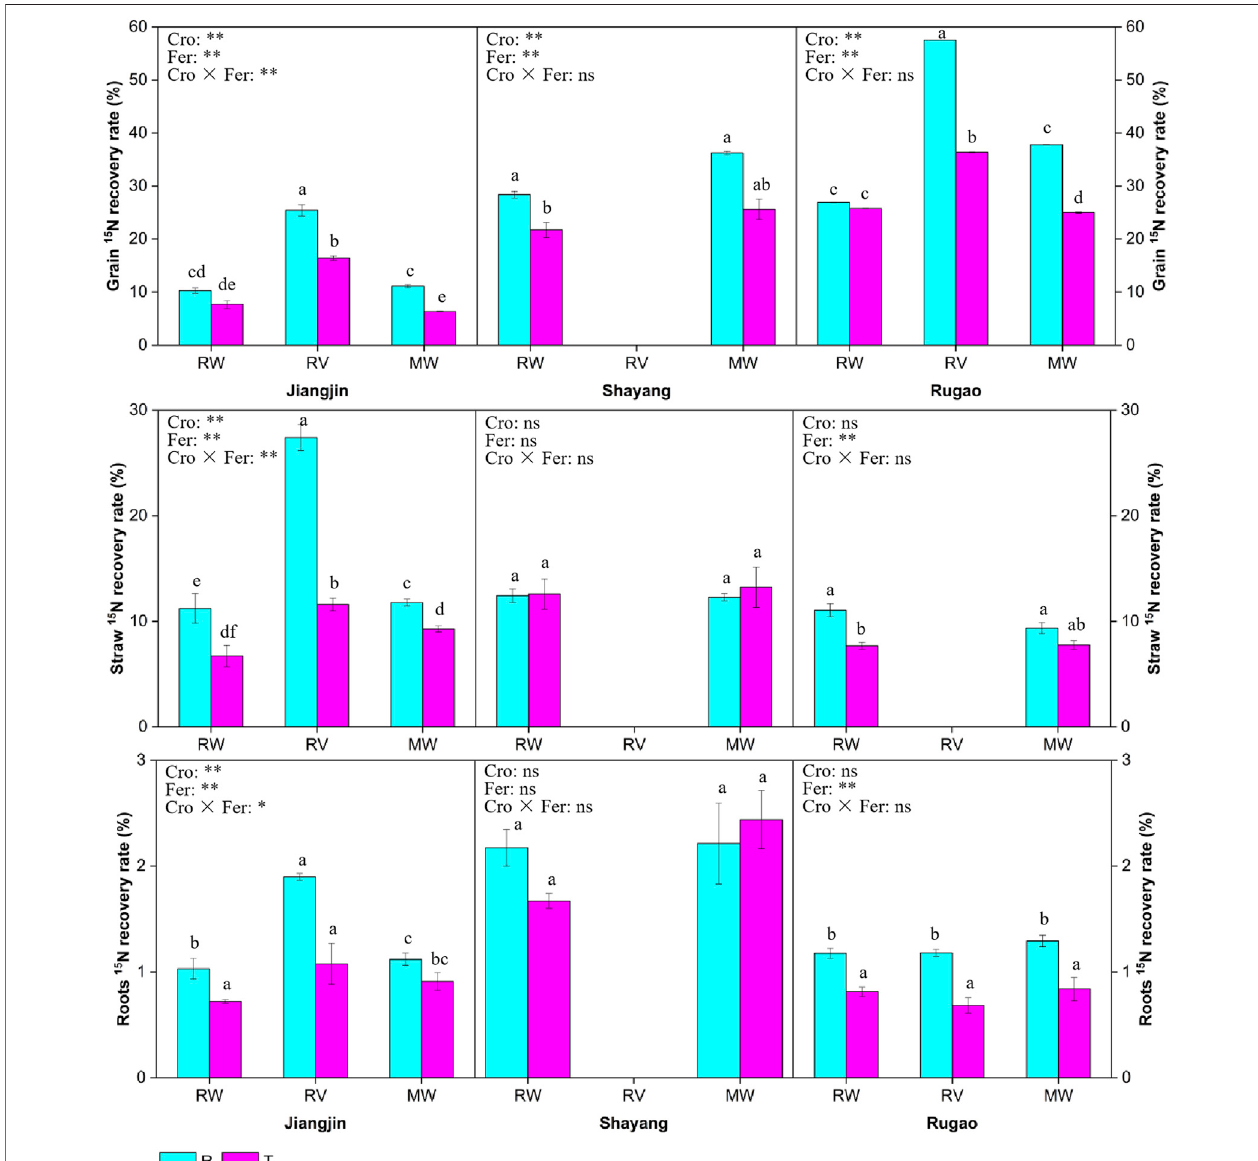
FIGURE 3 | 15 N recoveries in wheat/vegetable grain/stem/leaves, straw and roots in the three crop rotations at Jiangjin, Shayang and Rugao. Note: RW = rice – wheat rotation. RV = rice – vegetable rotation. MW = maize – wheat rotation. Error bars present the standard error of the measurements from three replicates. R = reducedfertilizerinput. T=traditionalfertilizer input. Differentsmallletters above thebars denote signi fi cance at the5%level. Cro= crop system. Fer = fertilization. Cro × Fer = the interactions of crop rotation and fertilization. ns, * and ** mean no signi fi cance, p < 0.05 and p < 0.01.